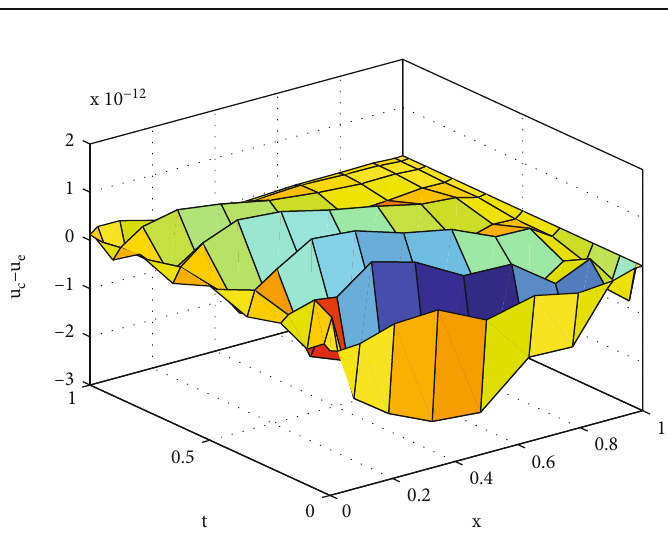
Figure 5: Errors of Chebyshev nodes for BLCM with m = n = 10 .